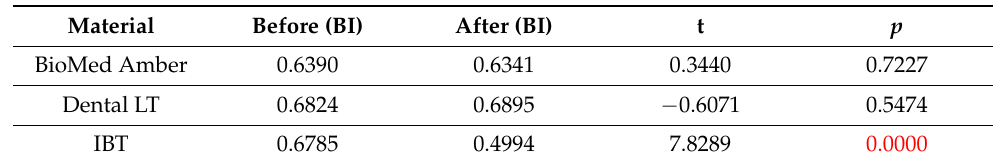
Table 16. Results of Student’s t -test for the comparison bone index values of the examined surfaces before and after the compression test ( t -value of Student’s t -test, p — p value; the statistical significance for p < 0.05 was presented in red).